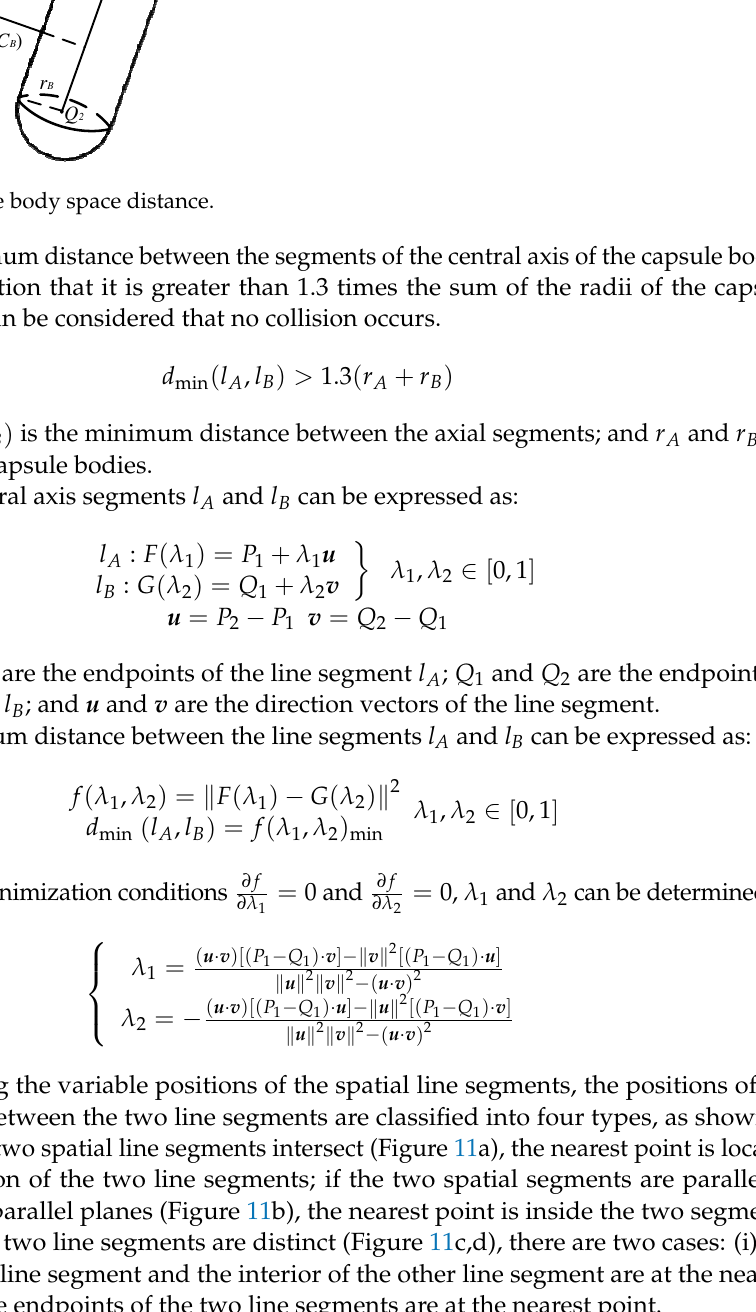
From the minimization conditions and